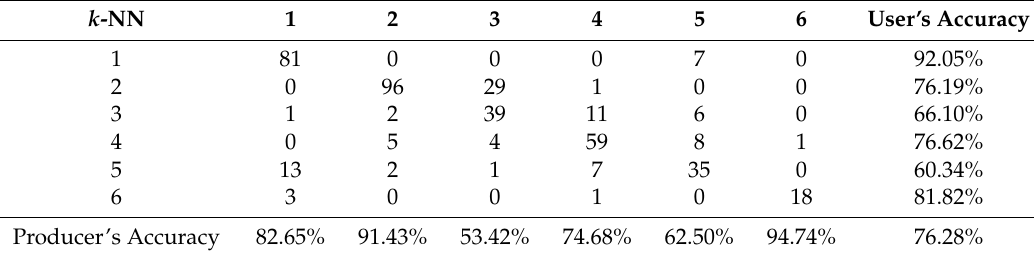
Figure 12. Classified map using the g k -NN method. Table 4. Error matrix using the k -NN method (Class name: 1, bamboo; 2, coniferous; 3, broadleaved; 4, mixed woodland; 5, brush; 6, barren land), Kappa = 0.706.